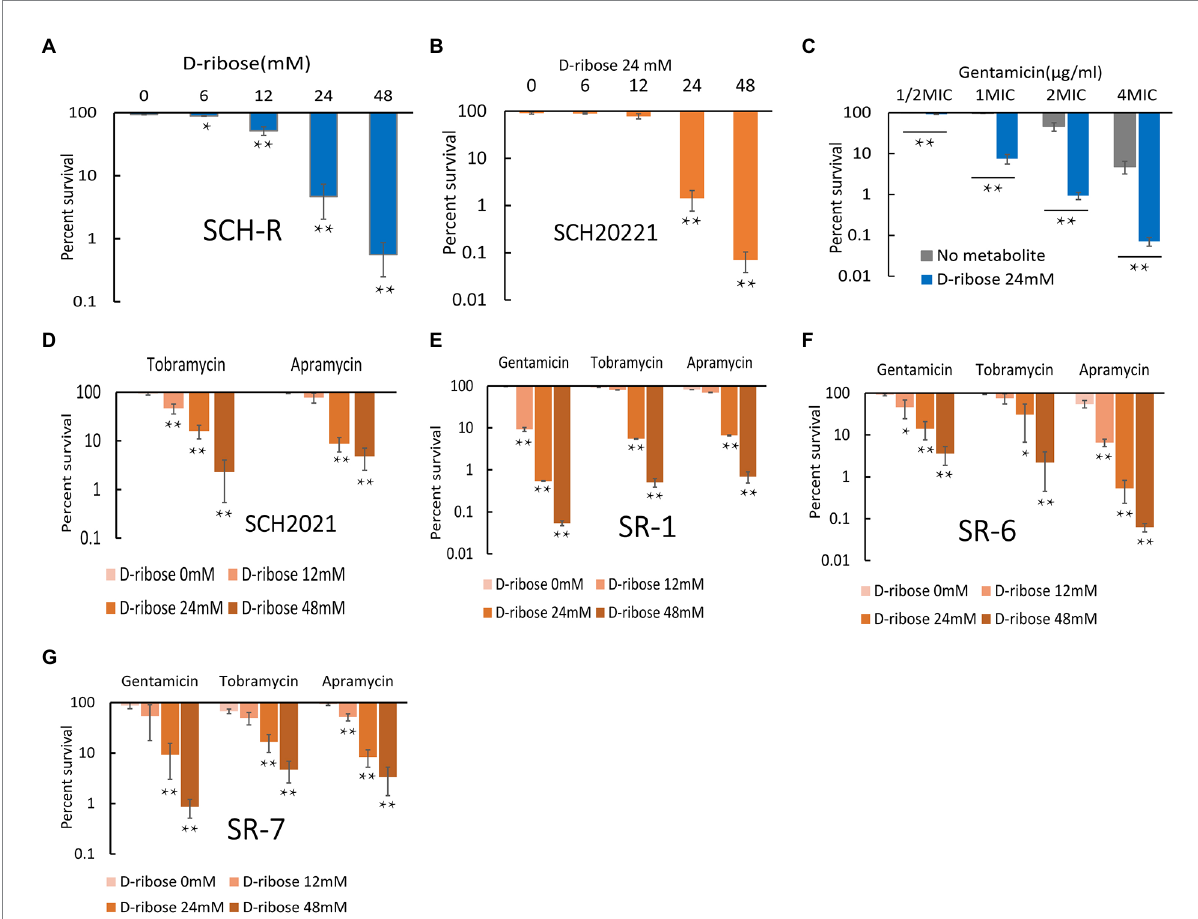
FIGURE 4 Effect of exogenous D-ribose on SCH-R and clinical isolates of drug-resistant Salmonella . (A) Percent survival of SCH-R in the presence of 1 MIC gentamicin by D-ribose dose. (B) Percent survival of SCH2021 in the presence of 1 MIC gentamicin by D-ribose dose. (C) Percent survival of SCH-R in the presence of 24 mM D-ribose by gentamicin dose. (D–G) Percent survival of clinical isolates SCH2021 (D) , SR-1 (E) , SR-6 (F) , and SR-7 (G) in the presence of different aminoglycosides (1MIC) by D-ribose dose. Results are displayed as the mean ± SEM and three biological repeats are carried out. Significant differences are identified ( *p < 0.05 and **p <